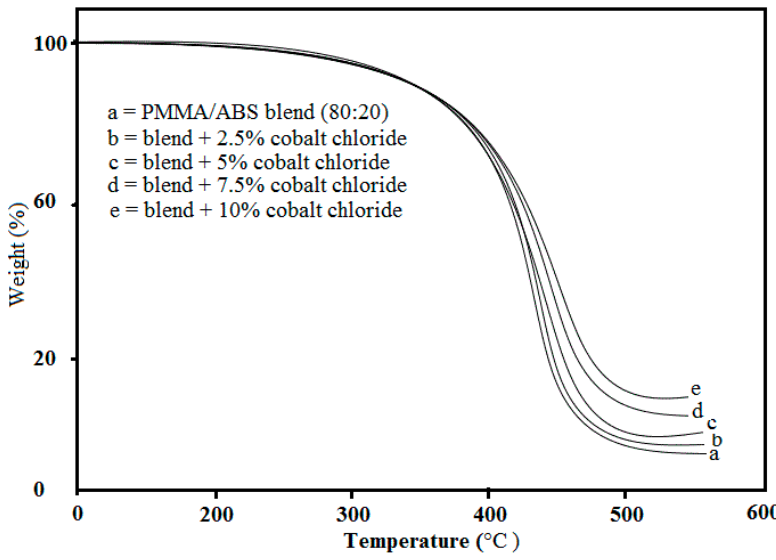
Figure 3. TGA thermogram of prepared PMMA/ABS/CoCl 2 composite.